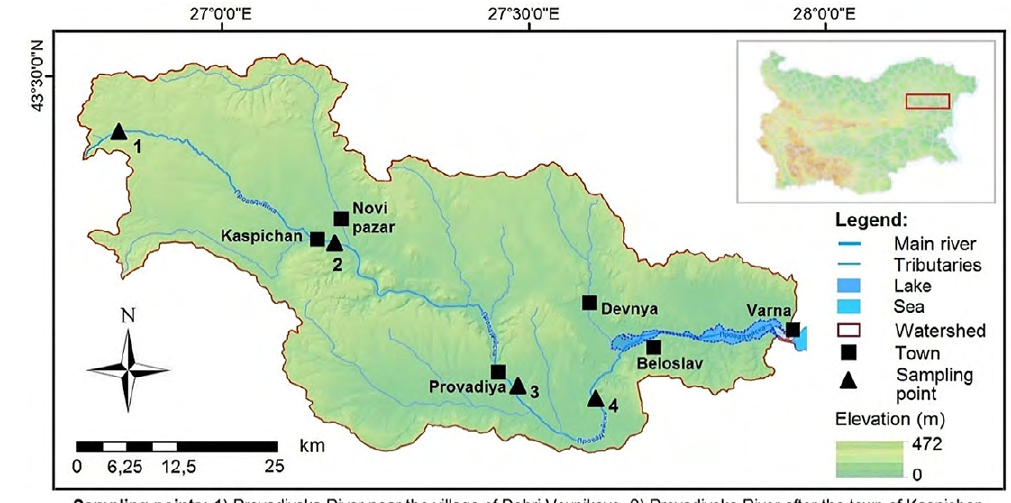
Figure 1. Map of the relief and drainage network showing the location of sampling points